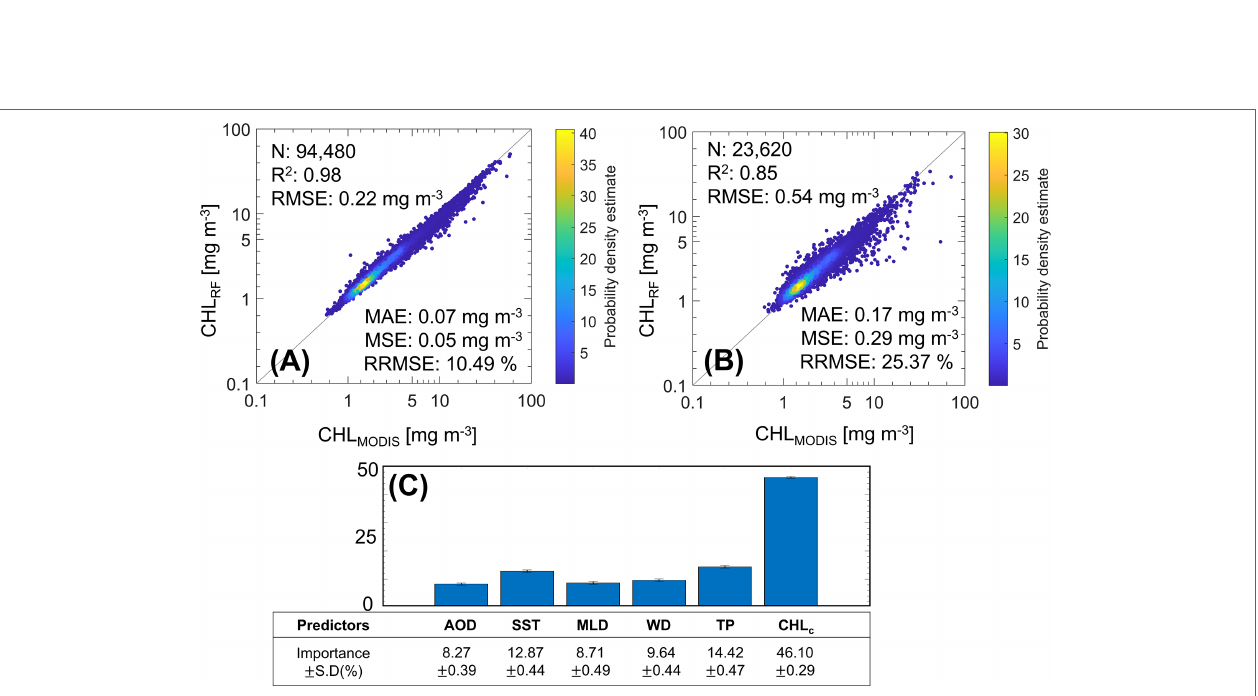
FIGURE 2 | Time series of monthly means of AOD (A) , SST (B) , MLD (C) , WD (D) , TP (E) , and CHL (F) from February (Feb.) 2003 to May 2021. Gray lines indicate the monthly mean predictor in each year from 2003 to 2019. Red lines show from February 2020 to May 2020 in the COVID-19 lockdown period (red shaded) and blue lines represent from February 2021 to May 2021.